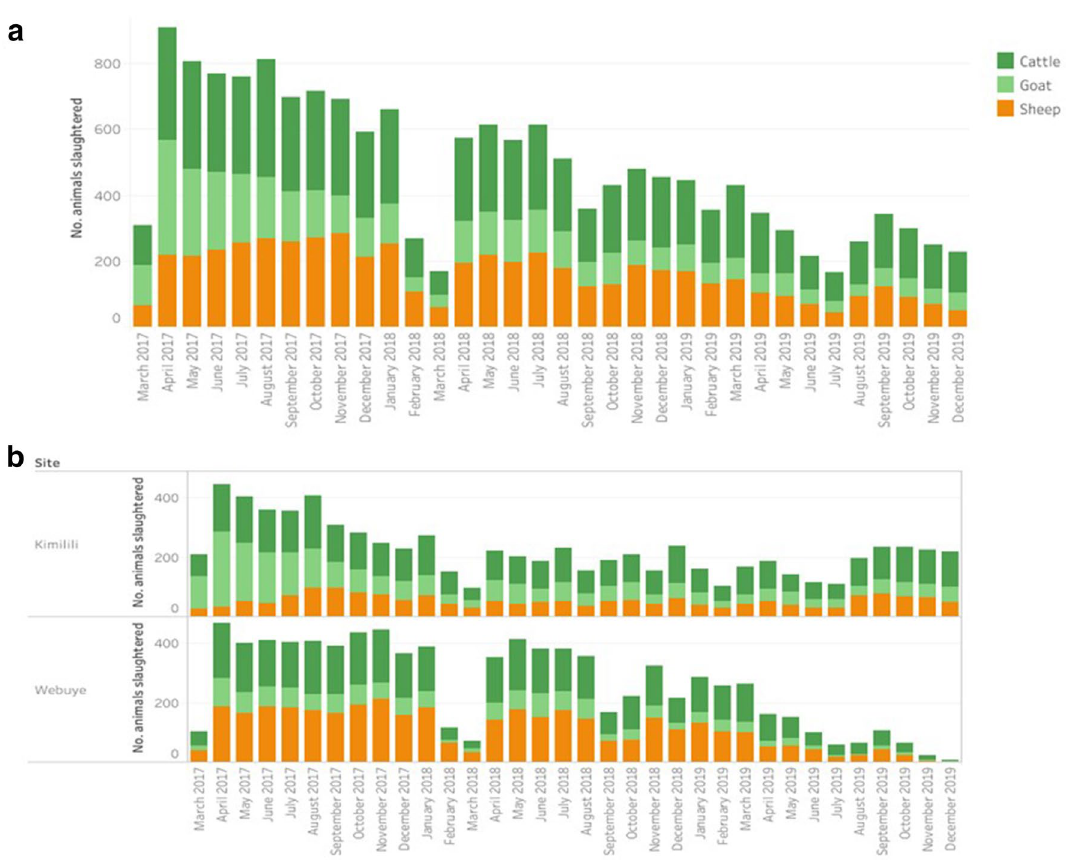
Figure 2. The number of reports submitted by the participating meat inspectors during each month of the study period (March 2017–December 2019) overall (a) , and stratified by slaughterhouse (b)